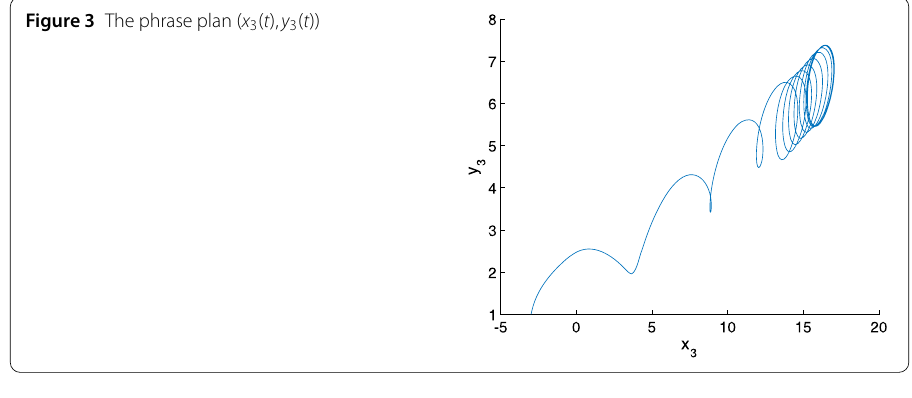
Figure 3 The phrase plan ( x 3 ( t ), y 3 ( t ))